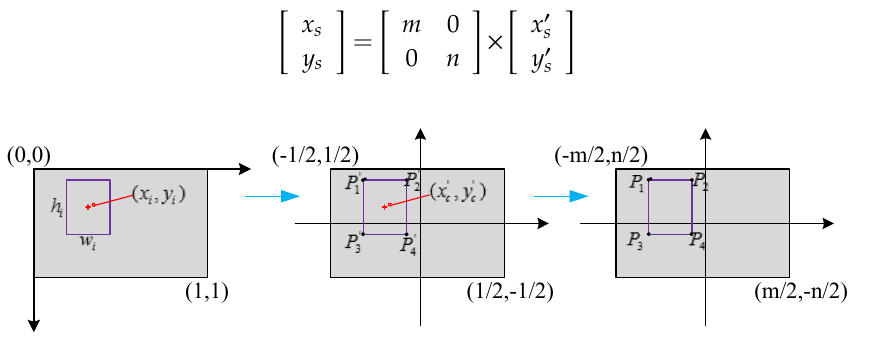
Figure 3. Coordinate conversion process.